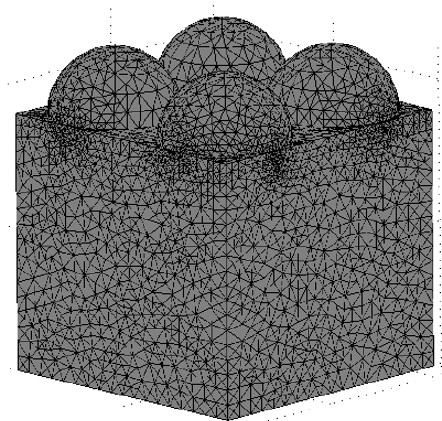
Figure 5. An example of a computational mesh for a geometric model with 4 hemispheres..